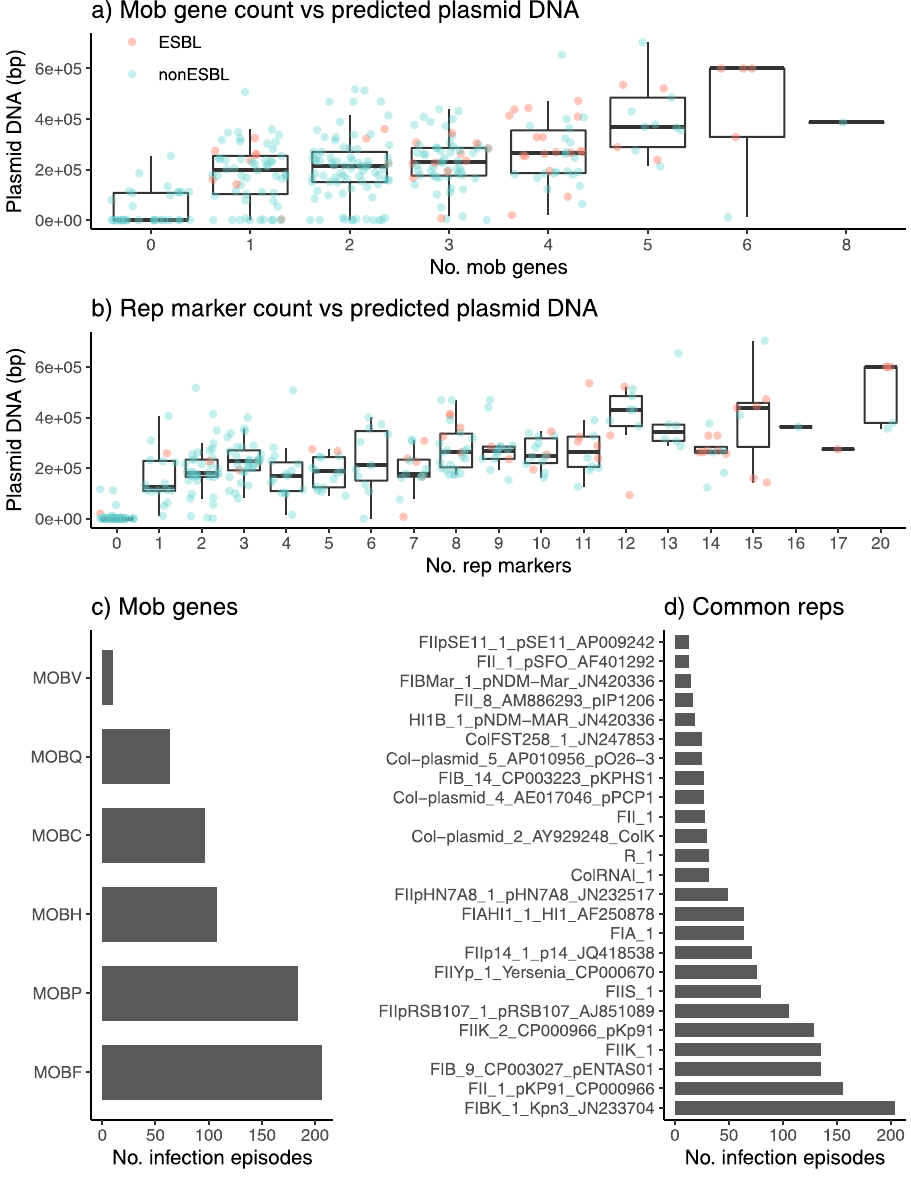
Fig. 4 Measures of plasmid number and diversity. Data used for this analysis was the fi rst isolate per unique infection episode, for 294 genomically- de fi ned infection episodes. Distribution of total DNA sequence (bp) in contigs assigned as plasmids are shown, strati fi ed by a number of mob genes identi fi ed per genome and b number of uniquely distributed replicon markers identi fi ed per genome. Each point represents a unique genome sequence and is coloured according to whether ESBL genes were detected in the genome (inset legend). Boxplots elements are: center line, median; box limits, upper and lower quartiles; whiskers, 1.5x interquartile range. Linear regression model fi t: Total plasmid DNA (kbp) ~79 + 18 *(# mob ) + 16 *(# rep ); p = 8 x 10 − 4 for mob ; p < 1 × 10 − 15 for rep . c Frequency of individual mob types. d Frequency of 25 common replicon markers (each present in ≥ 5% of